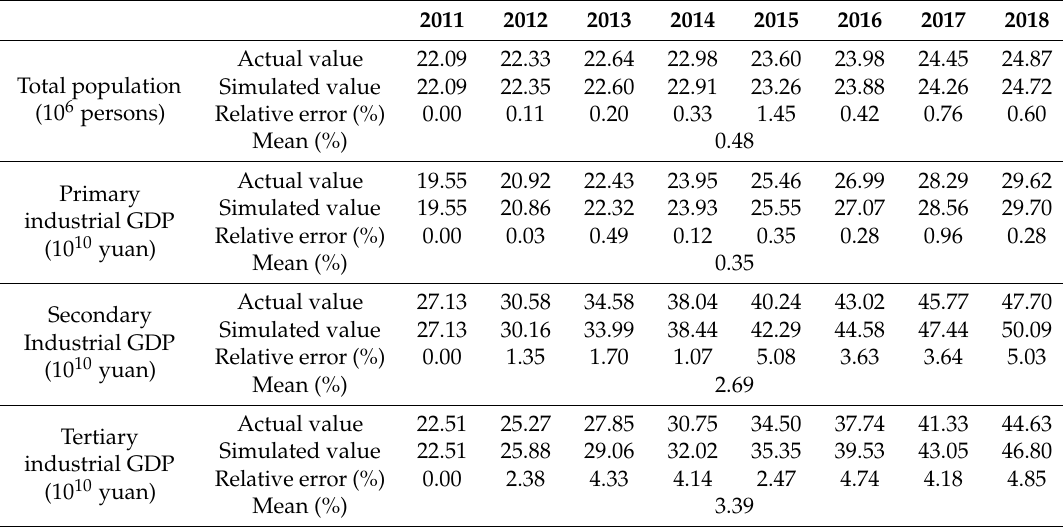
Table 2. Historical data test results of the SD model